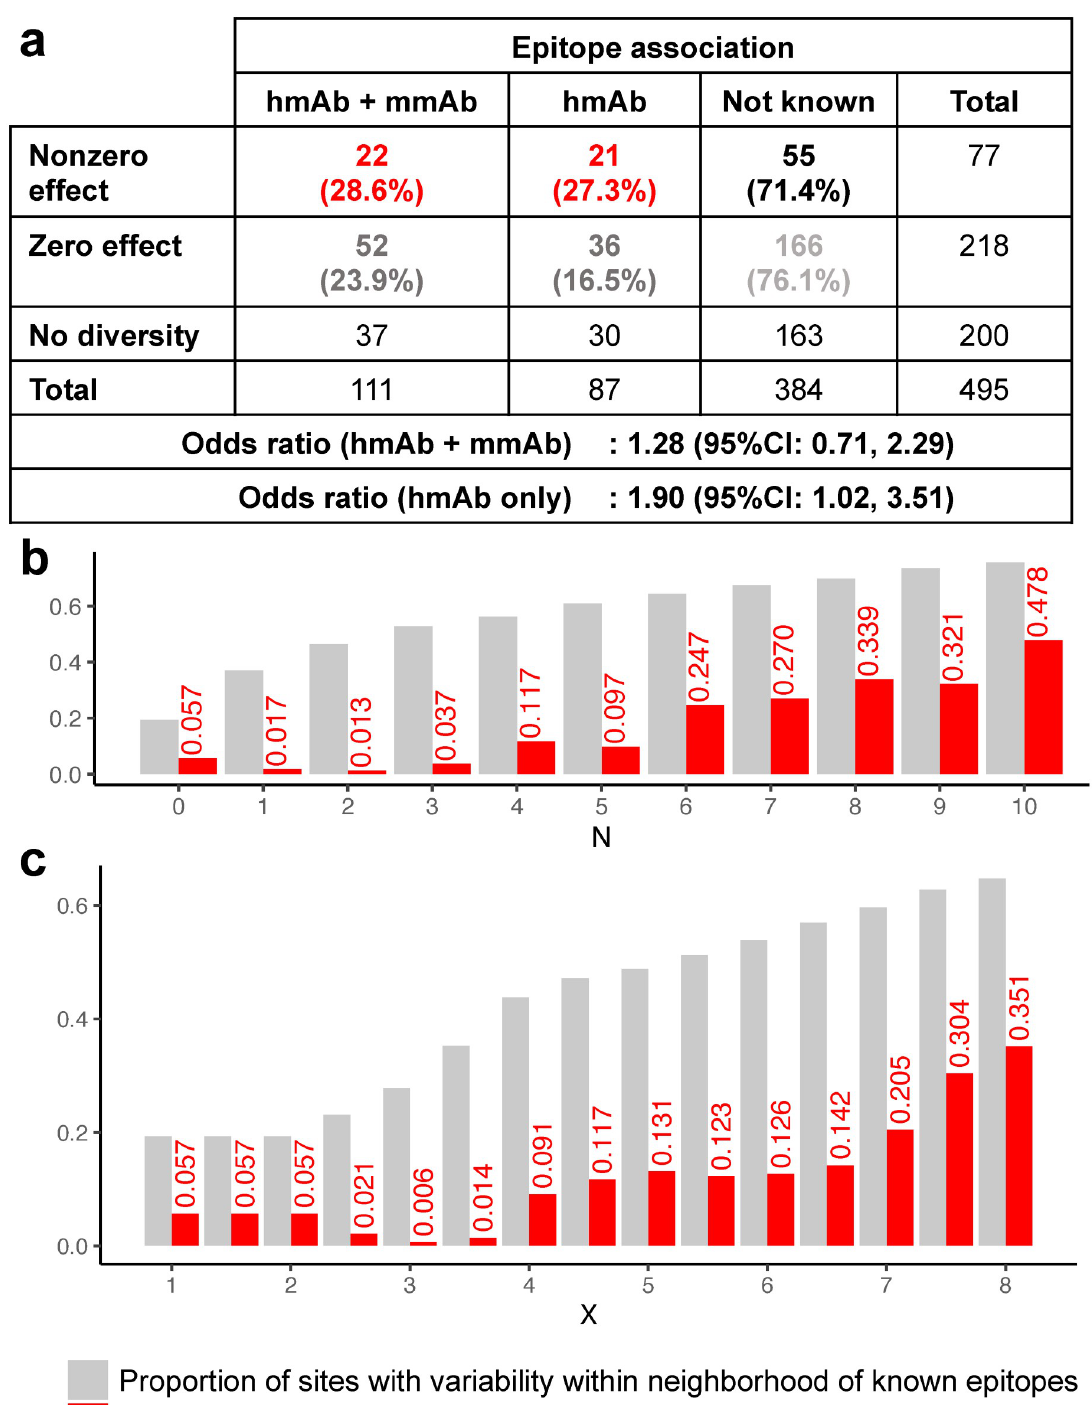
Fig 2. Association between effect sites and known epitopes of neutralizing antibodies. a) Number and percentage of sites with and without effects by whether or not they are part of known epitopes. Odds ratios were calculated by either considering epitopes of both human-derived monoclonal antibodies (hmAb) and murine-derived monoclonal antibodies (mmAb) and when only restricted to hmAb epitopes. b) Defining neighborhoods of known hmAb epitopes as positions within N sites away (linear distance), the probability of nonzero effect sites being within the neighborhood at random (red) are contrasted against the proportion of variable sites that were